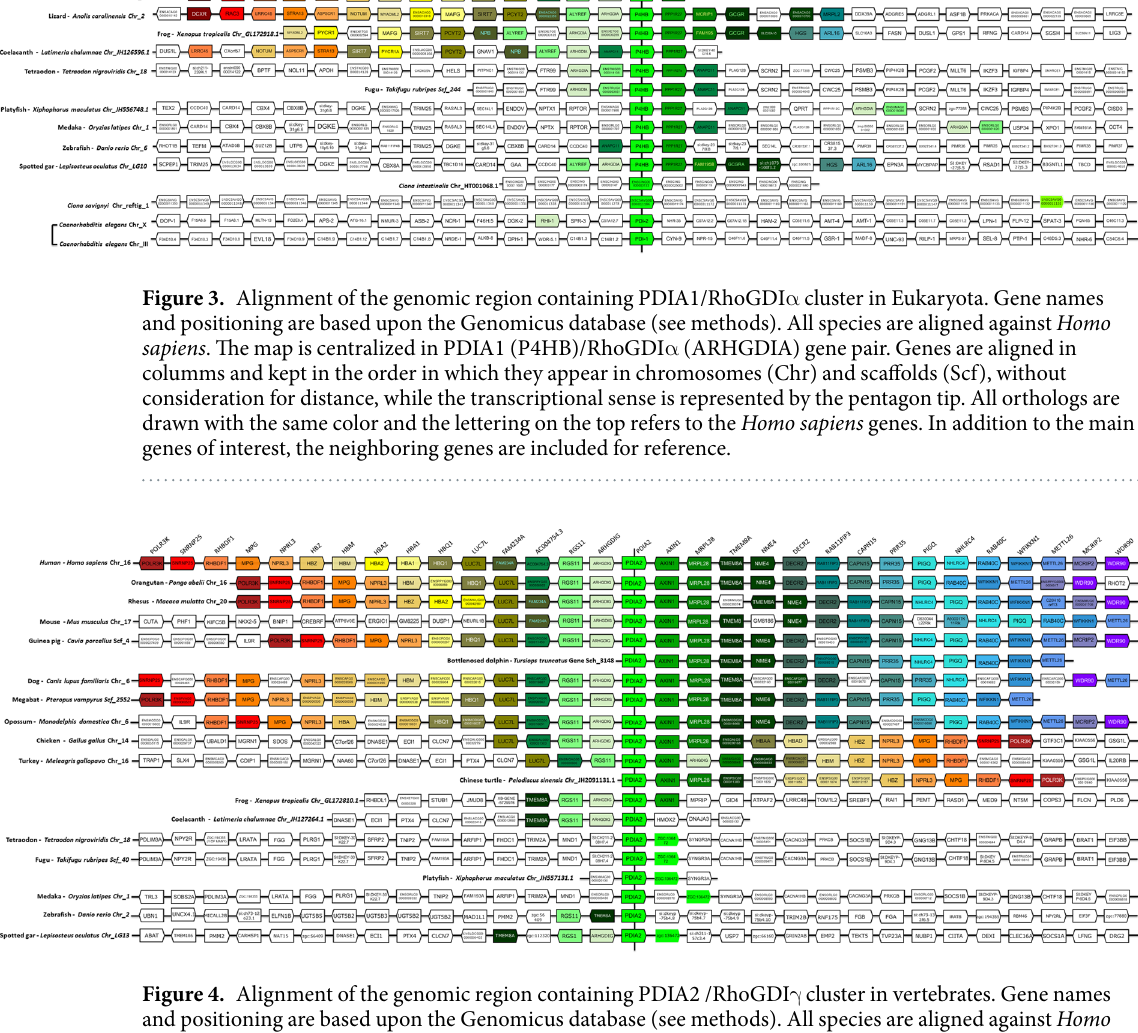
were able to find enhancer sequences described to potentially associate with all PDI-RhoGDI pairs described in this work (Table 2). Since these PDI-RhoGDI pairs display common enhancer blocks, they fulfill the initial requirements to be classified as conserved ancestral microsyntenic pairs or CAMPs 17 .